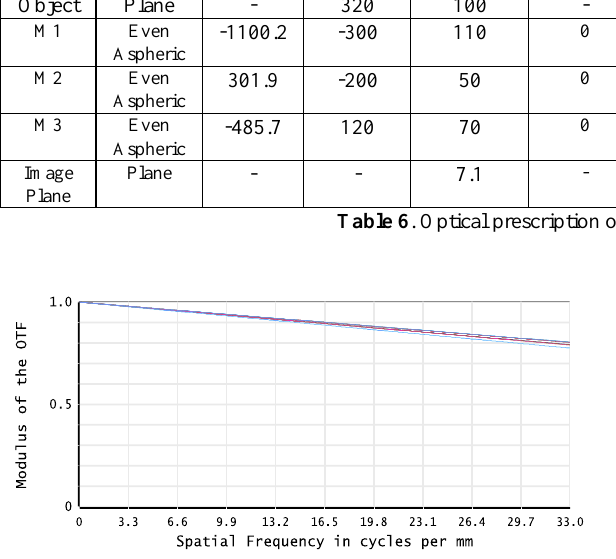
Figure 5. Resulting MTF graph of the TMA Telescope Design [400-2500 nm]